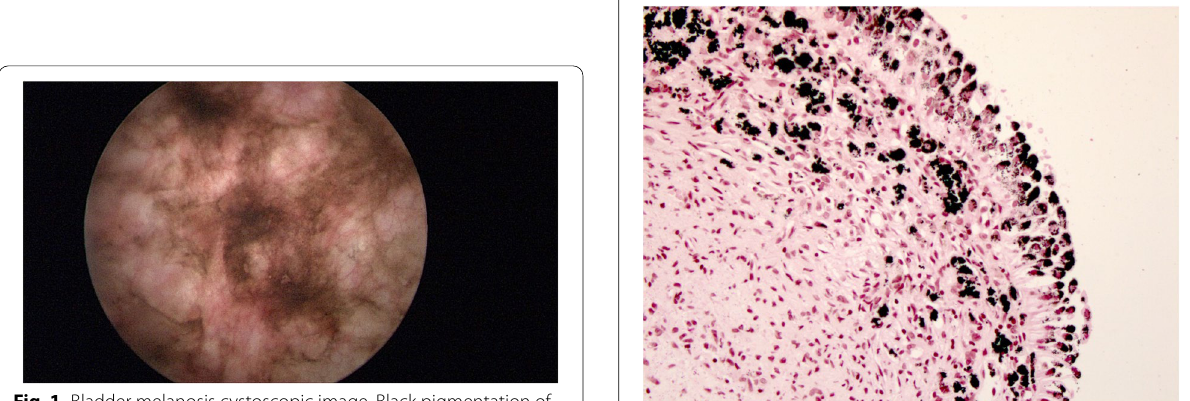
Fig. 1 Bladder melanosis cystoscopic image. Black pigmentation of bladder mucosa noted at the time of cystoscopy, involving the entire bladder